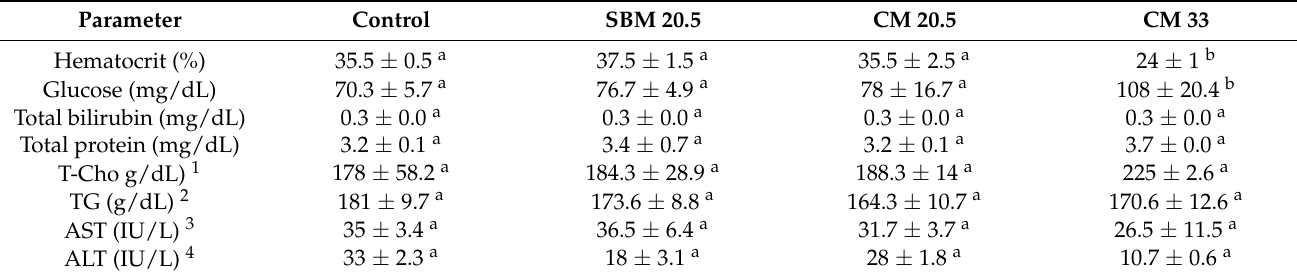
Table 8. Serum biochemistry parameters obtained after 60 days feeding period in red seabream fed diets formulated by replacing fish meal with camelina meal at 0% for reference diet (CM0), 20.5 g/kg with soybean mean (SBM20.5), 20.5 g/kg with camelina meal (CM20.5) and 33 g/kg camelina meal (CM33). Parameter